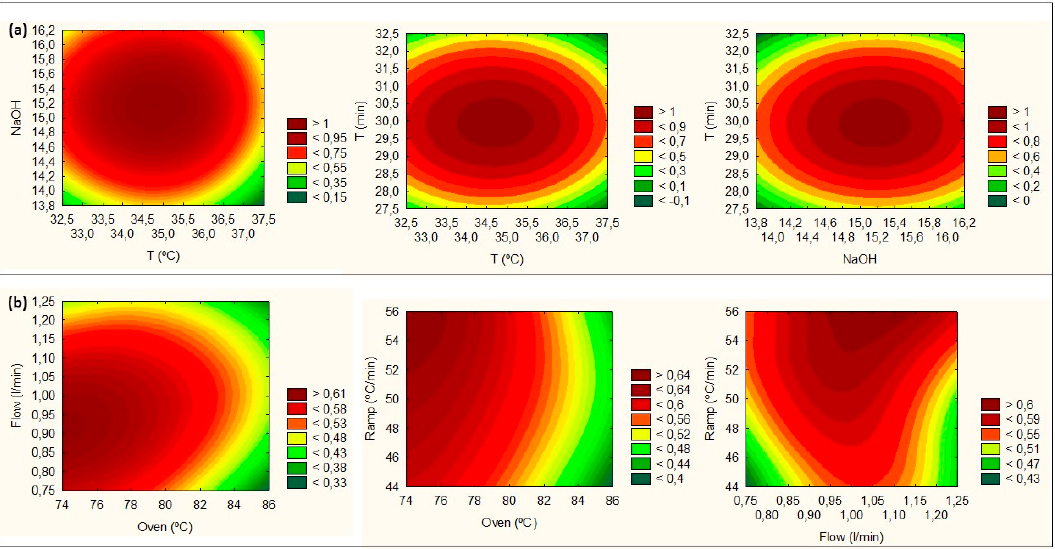
Figure 3. Robustness analysis results of all CMPs through the desirability plots. ( a ) Desirability analysis results for HS-SPME(DVB / CAR / PDMS), simultaneous analysis of TPA, and IP robustness results. ( b ) The desirability analysis for GC-MS(BP20), simultaneous analysis of TPA, IP, PR, TF, and SF robustness results.